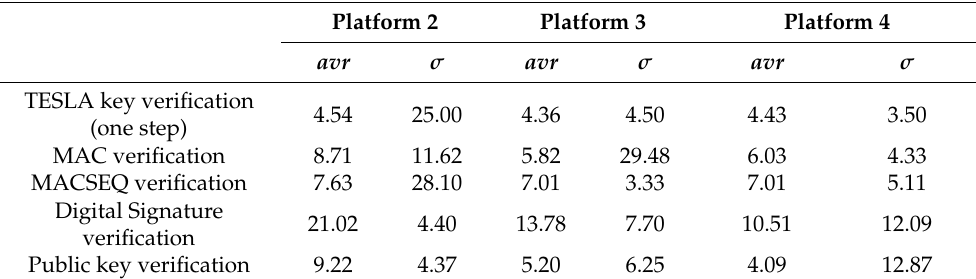
Table 5. Execution time degradation factors in terms of mean value avr and standard deviation σ on the three embedded boards, i.e., platforms 2, 3 and 4, with respect to the standard PC, i.e., platform 1, for all the OSNMA functions reported in Table